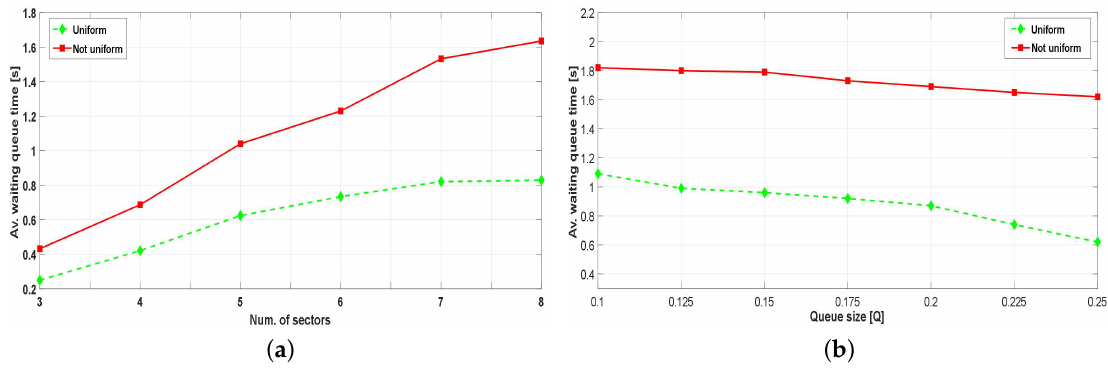
Figure 5. Queue issues with round-robin scheduling. ( a ) Average waiting queue time vs. number of sectors. ( b ) Average waiting queue time vs. queue